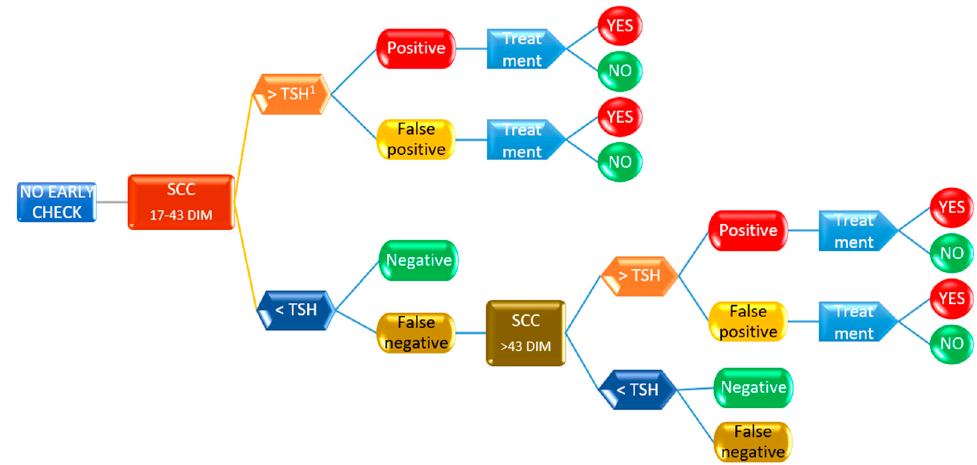
Figure 3. Summary of the decision tree model calculating the risk for intramammary treatment based on SCC in the B period (17–43 days from calving). All the potential outcomes were considered for each of the nodes (positive, false positive, or negative), leading to the chances of a treatment. See Supplementary Figure S2 for the probability of each outcome. 1 TSH: threshold specific for each marker.